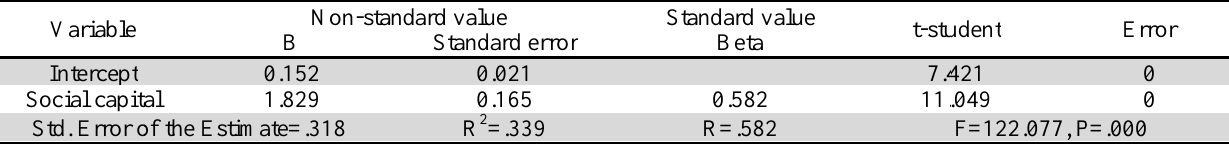
Variable Intercept Social capita Std. Error